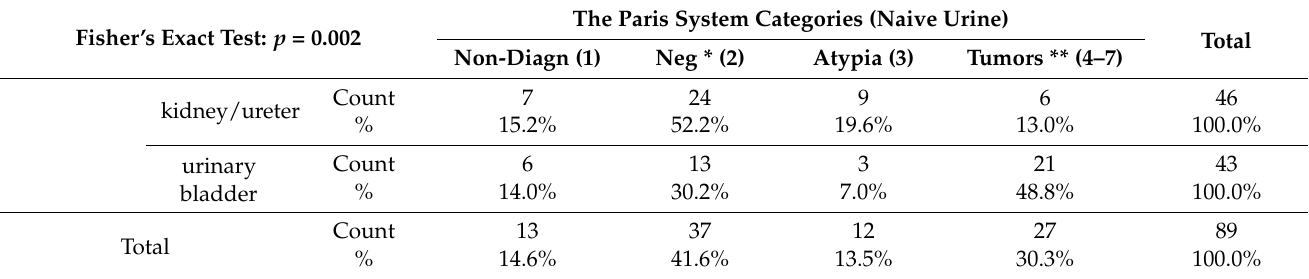
Table 3. Distribution of naive urine samples into The Paris System